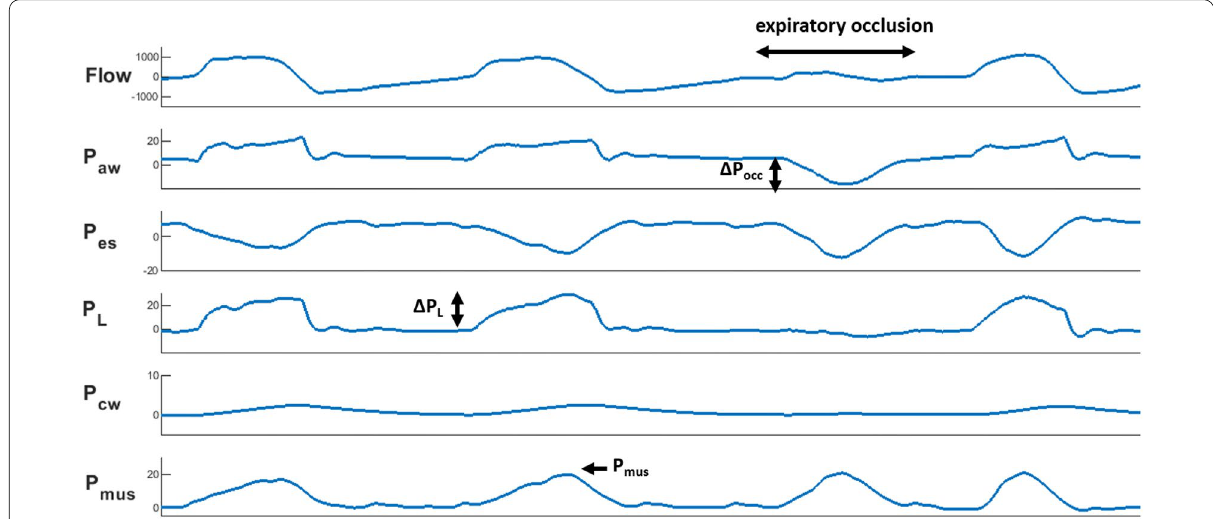
Fig. 1 Flow and pressure tracings showing an expiratory occlusion maneuver. From top to bottom: flow (in mL/s), airway pressure ( P aw ), esophageal pressure ( P es ), transpulmonary pressure ( P L ) ( P aw – P es ), chest wall elastic recoil pressure ( P cw ) (tidal volume respiratory muscle pressure ( P mus ) ( P cw – P es ) (pressures in cmH 2 O). During an expiratory occlusion maneuver the patient inhales against a closed valve, resulting in a decrease in airway pressure. The maximal deflection in P aw from positive end-expiratory pressure is defined as occlusion pressure (∆ P occ ). From this ∆ P L and P mus were computed and compared with true dynamic lung stress (increase in P L from onset to peak during inspiration) and true respiratory effort (peak